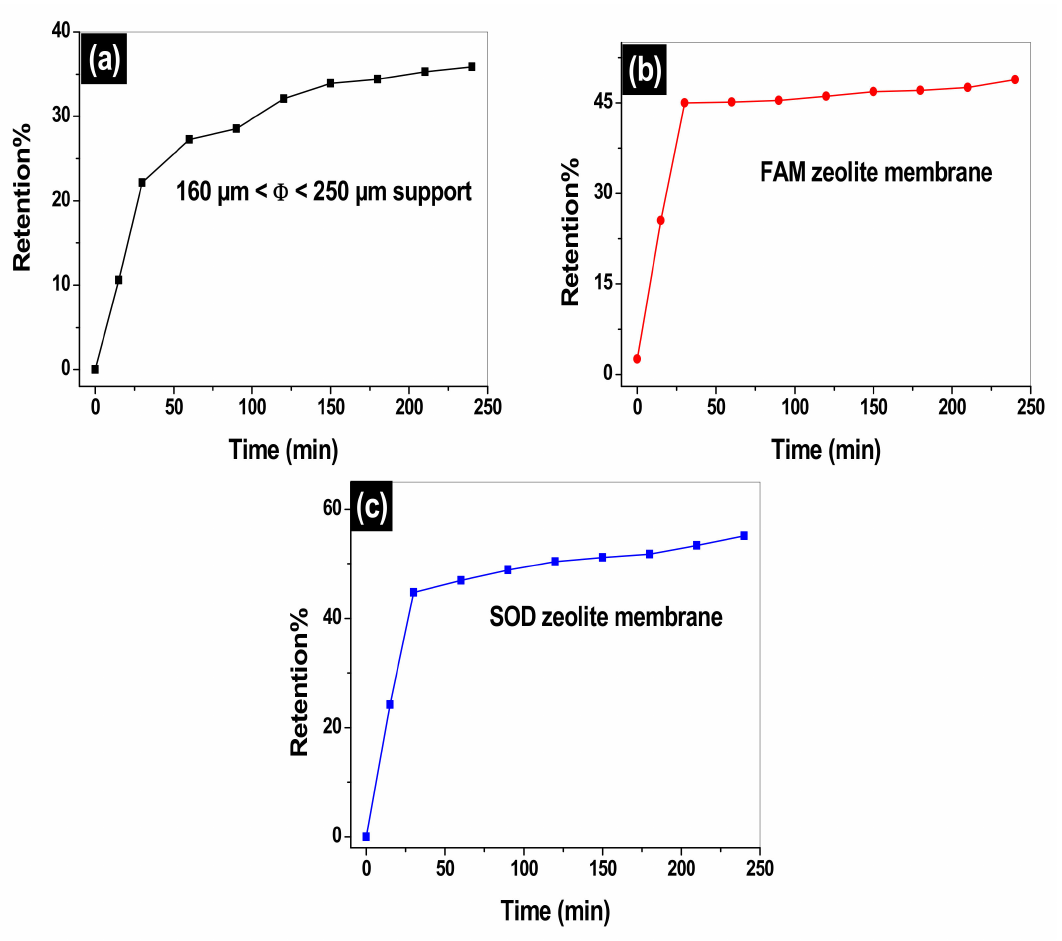
Figure 10. MO percentage of retention versus filtration time on: 160 µ m ≤ Φ ≤ 250 µ m support ( a ), faujasite (FAM) ( b ) and sodalite (SOM) ( c ) composite zeolite/clay